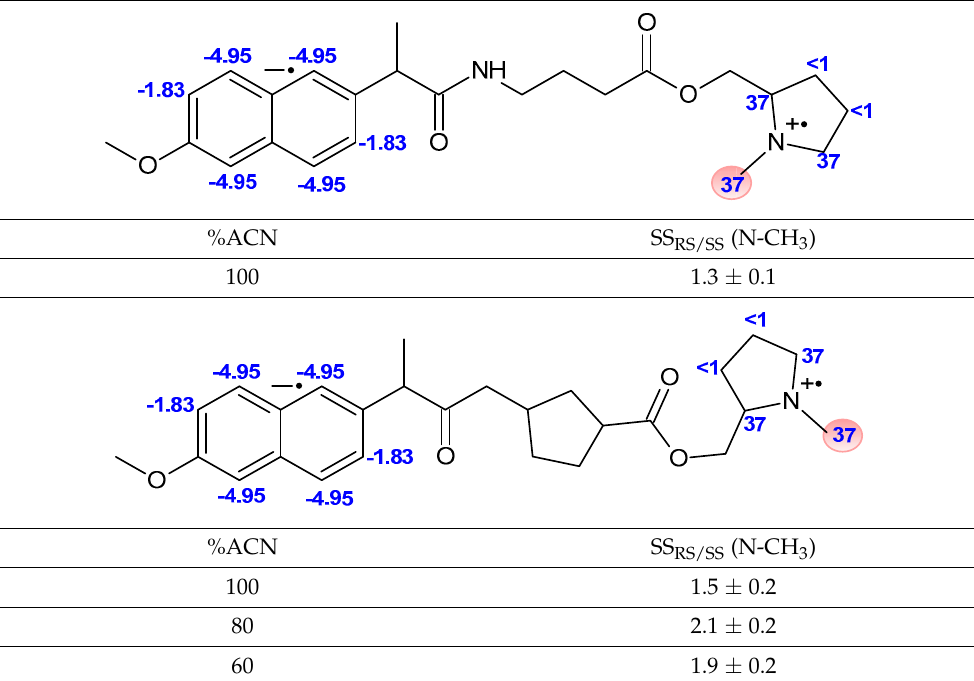
Table 1. SS values—the ratio of CIDNP coefficients (K) of protons (marked with red circles) for ( R , S )- and ( S , S )-diastereomers of dyads III (top) and IV (below), and corresponding HFI constants (in G) in BZ [20].